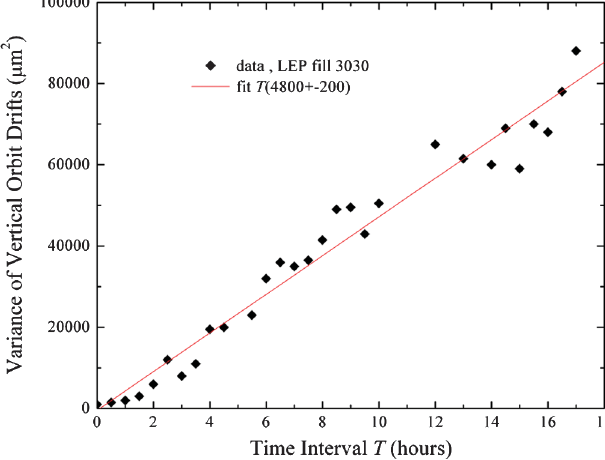
FIG. 9. (Color) Tevatron proton orbit 2nd difference variance. Dashed lines are linear fits of the ATL-like component of the